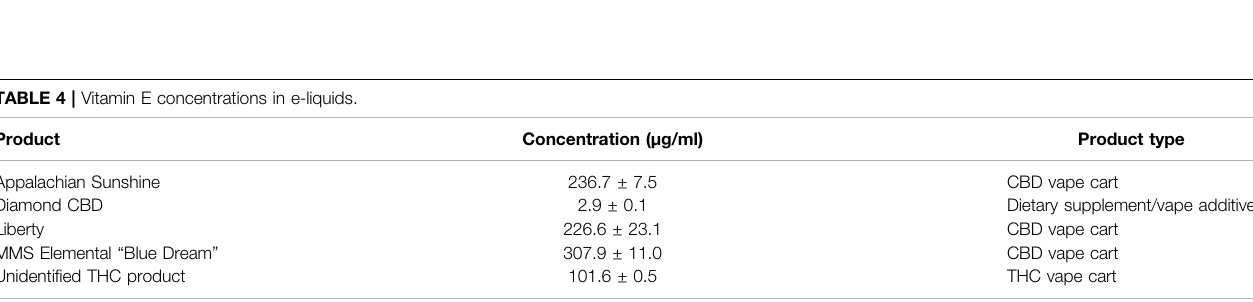
TABLE 4 | Vitamin E concentrations in e-liquids.